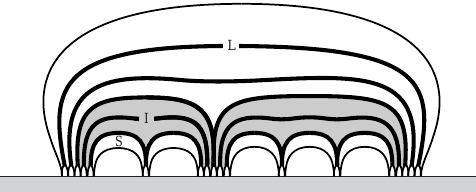
Figure 11. The coronal tectonics model, showing a schematic of a coronal loop consisting of many sub-volumes, each linked to a separate photospheric source and divided from one another by sep- aratrix surfaces. The motions of the footpoints produce a myriad of current sheets along the separatrices, which dissipate impulsively and produce